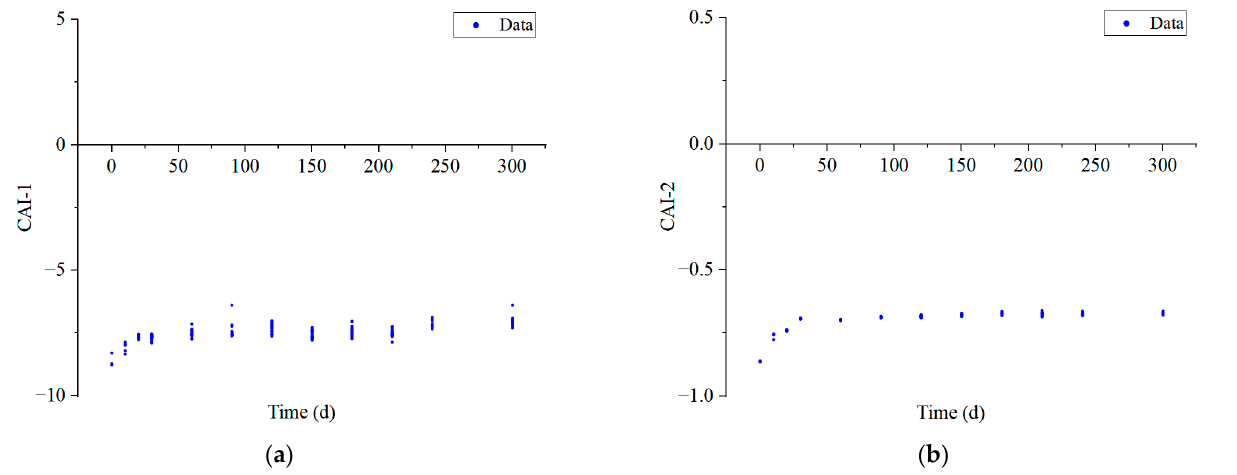
Figure 12. ( a ) CAI-1 and ( b ) CAI-2 indices of groundwater in goaf